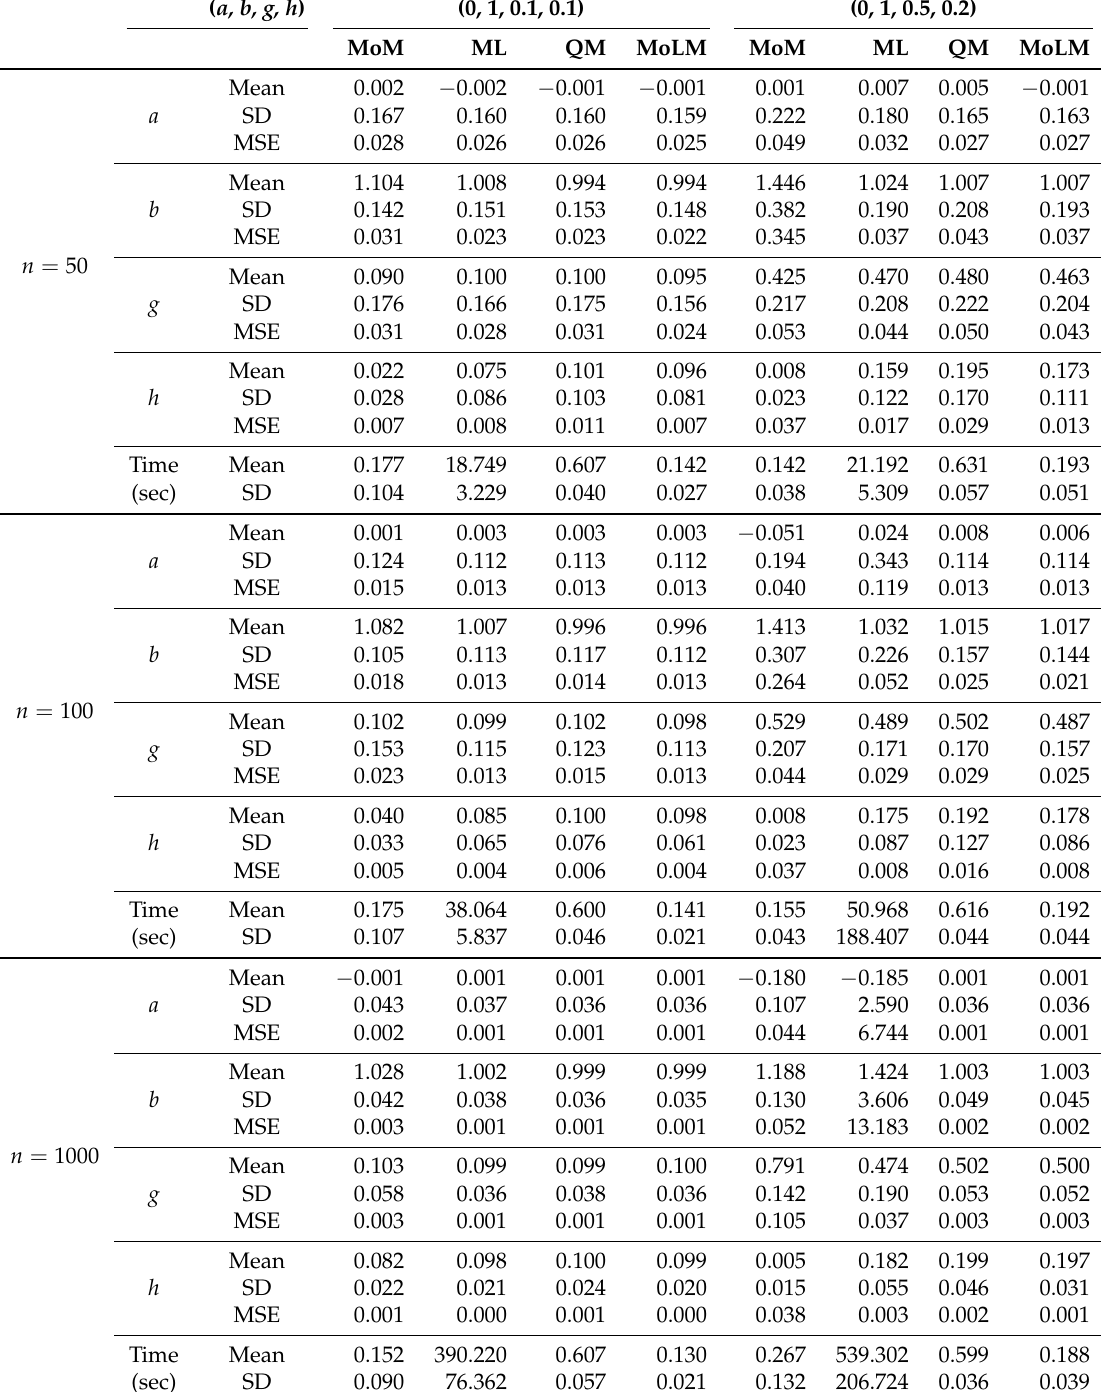
Table 1. Summaries of g-and-h parameter estimates by various methods on simulated